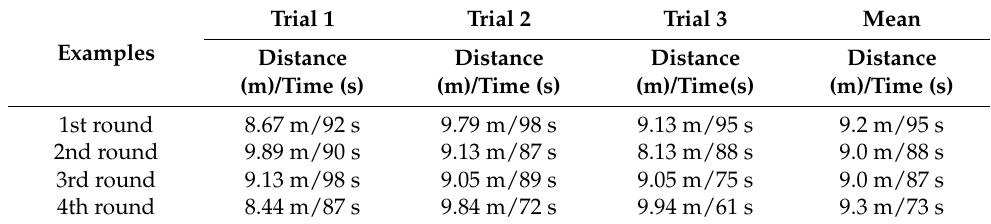
Table 1. Experimental data for different trials.